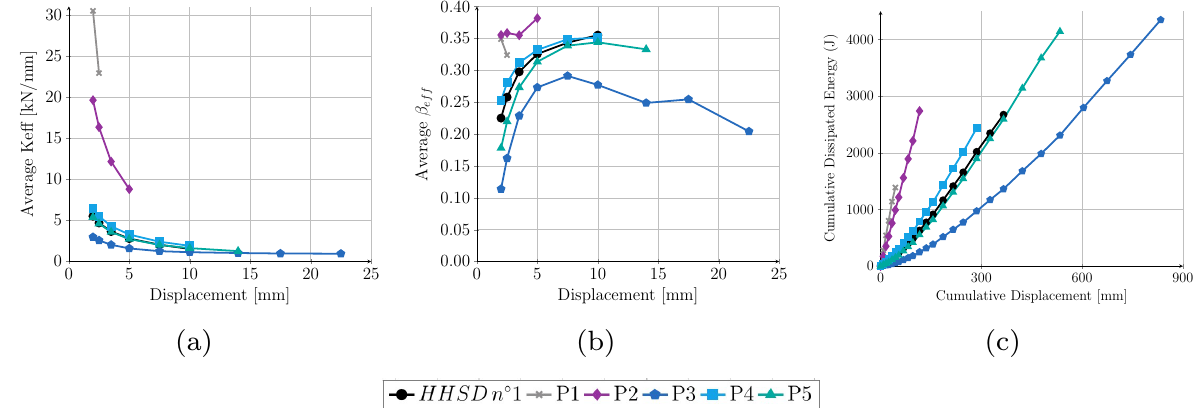
Figure 9. Relevant parameters for P3, P4 and P5. Average values for the three cycles at the same applied displacement: ( a ) Effective stiffness and ( b ) effective damping. ( c ) Cumulative dissipated energy vs. cumulative